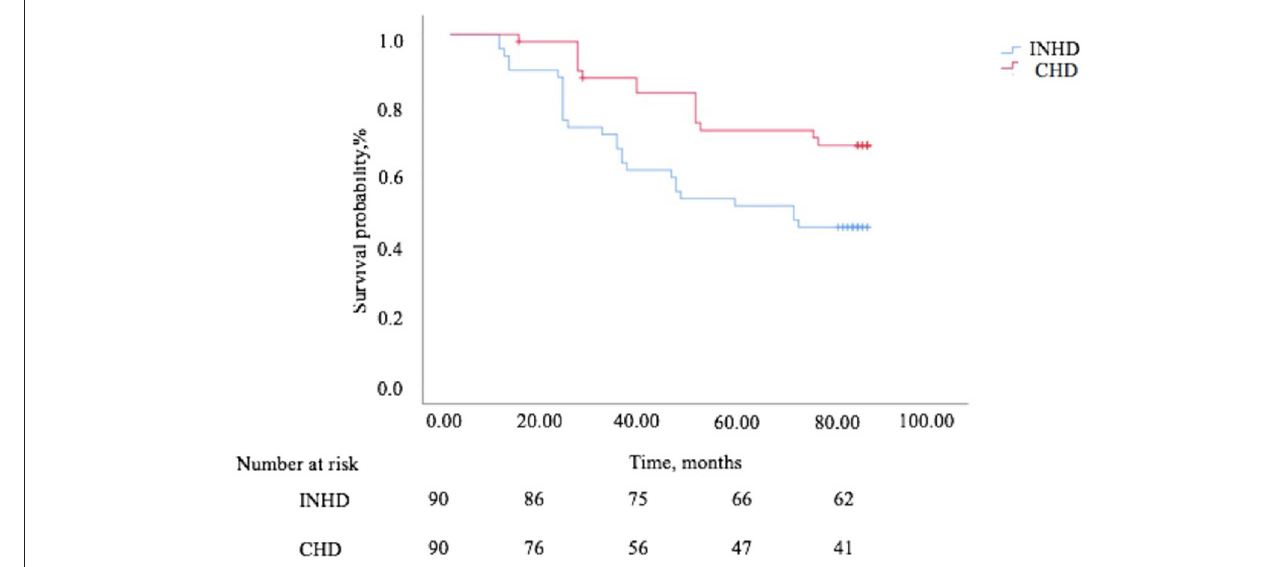
FIGURE 4 | The Kaplan–Meier survival curves comparing patients undergoing INHD and CHD in terms of mortality.